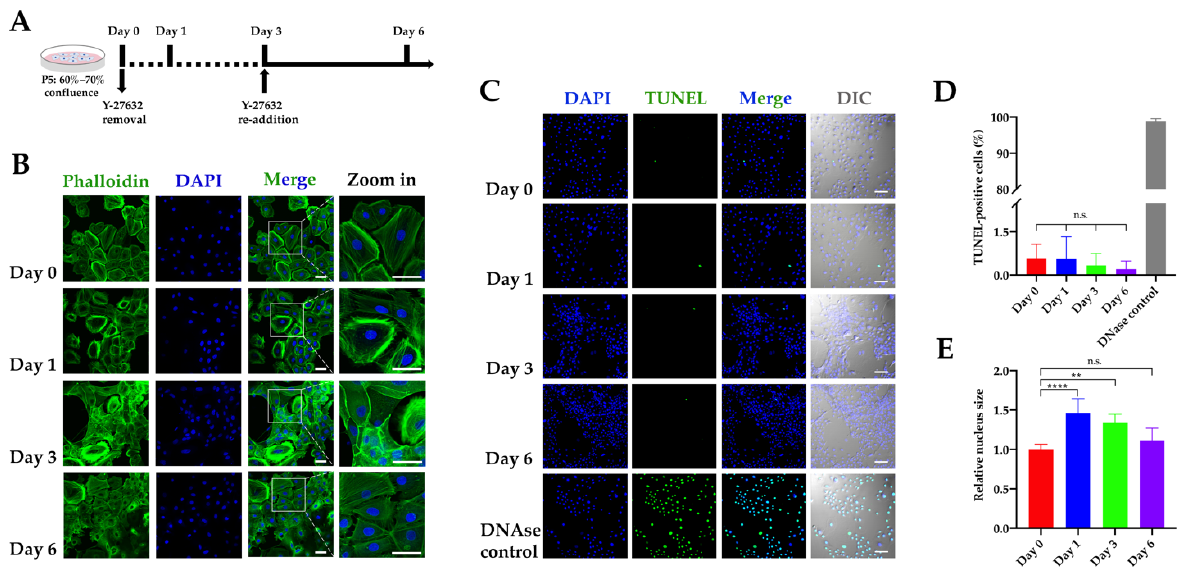
Figure 2. Effect of Y-27632 on the cytoskeletal dynamics and apoptosis of RLKs. ( A ) Experimental scheme. Cells were continuously cultured in MTCM with Y-27632 till passage 5. Then, Y-27632 was removed from the culture medium when cells reached 60–70% confluence on day 0 and re-added to the culture medium on day 3. Cells on day 0, 1, 3, and 6 were harvested for analysis. ( B ) Cytoskeletal reorganization in RLKs following Y-27632 removal and re-addition. Actin filaments were stained with Phalloidin-iFluor 488 (green) and nuclei were stained with DAPI (blue). Scale bars, 50 µ m. ( C ) Representative images of TUNEL-positive nuclei (green) and DAPI-stained nuclei (blue) in RLKs at different time points. DNAse-treated cells were used as a positive control. Scale bar, 100 μ m. ( D ) Quantification of TUNEL-positive cells ( n = 6 six random separate fields; n.s. = non-significant; one-way ANOVA). ( E ) Relative nucleus area of RLKs at different time points. Data were normalized with the average nucleus size on Day 0 ( n = 6 six random separate fields; **** p < 0.0001, ** p = 0.0017, n.s. = non-significant; one-way ANOVA).